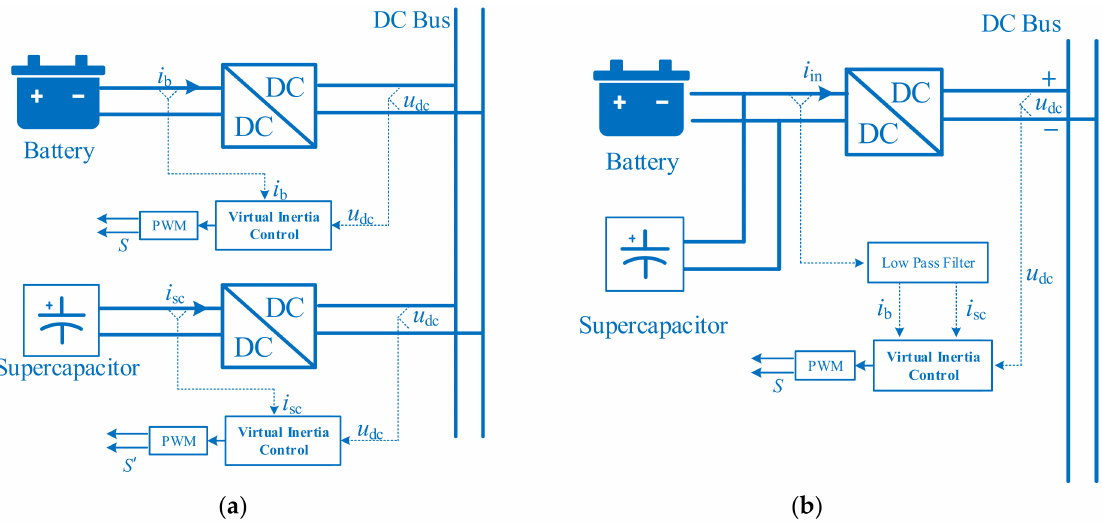
Figure 6. HESS topology in dc MGs: ( a ) a multi-converter parallel topology and ( b ) a multi-ports converter